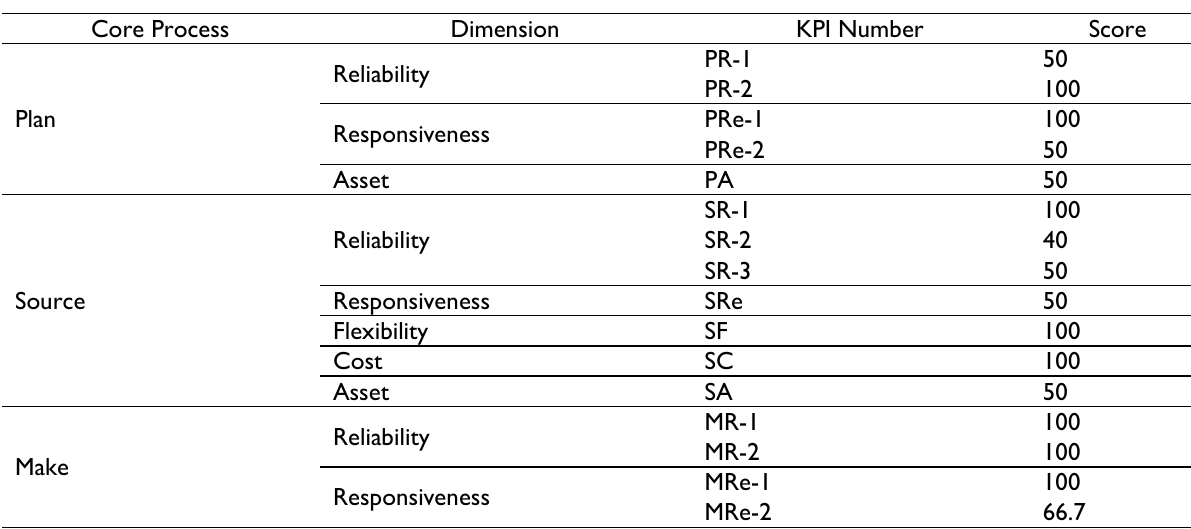
Table 5. KPI Normalized Value Core